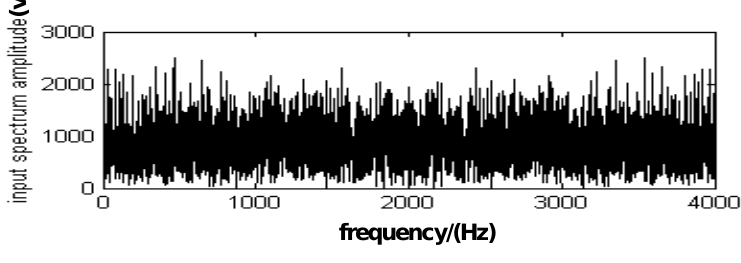
Figure 5. spectrum of input